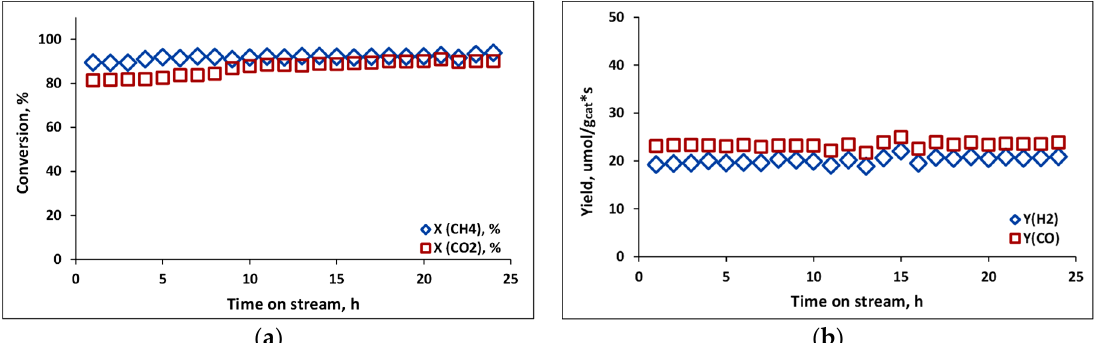
Figure 10. Dependence of ( a ) CO 2 -CH 4 conversion and ( b ) H 2 and CO yield on TOS in DRM over the 5%Co-Rh(95:5)/Al 2 O 3 catalyst at CH 4 :CO 2 = 1:1, t = 700 ◦ C, P = 1 atm, GHSV = 1500 h − 1